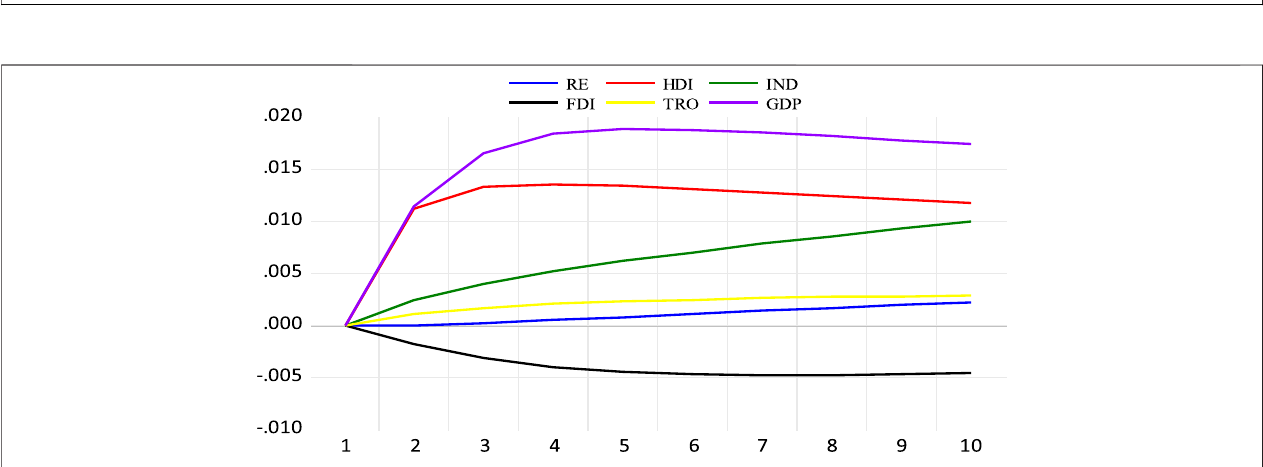
FIGURE 1 | Panel VAR impulse response functions for high income countries: Reaction of CO 2 emissions (CE) to renewable energy consumption (RE), human development index (HDI), industrialization (IND), foreign direct investment (FDI), trade openness (TRO) and economic growth (GDP) one standard deviation shock.